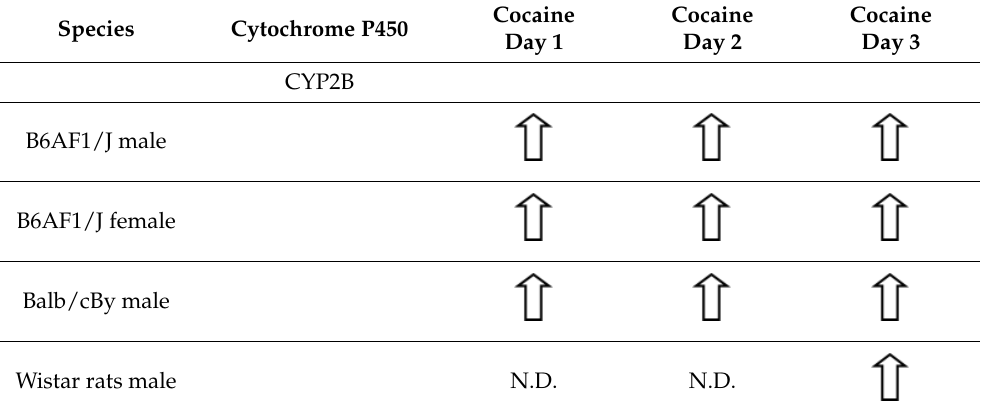
Table 1. Impact of the activation of brain dopaminergic pathways by different ligands of dopamin- ergic receptors on the activity and protein levels of cytochrome P450 (CYP) isoforms in rat liver microsomes.